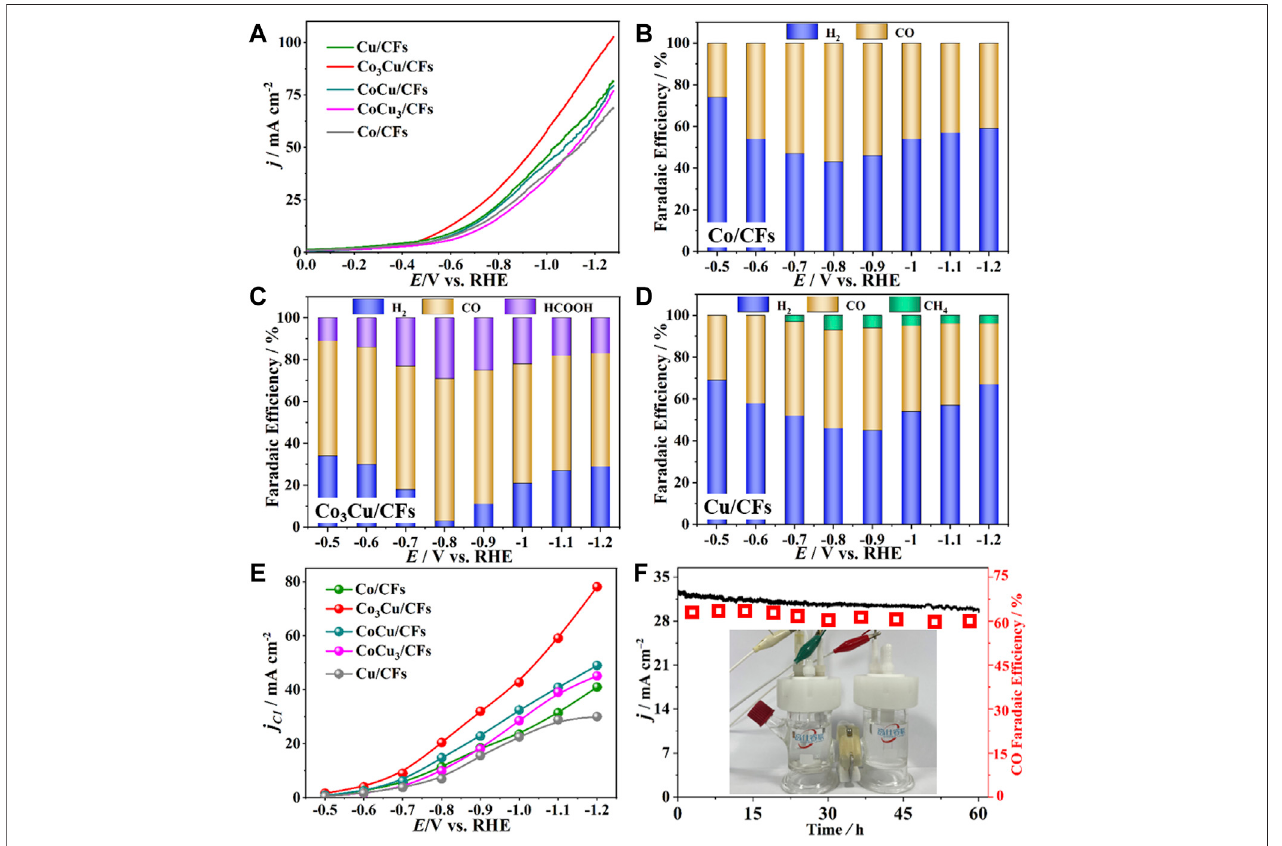
FIGURE4|(A) LSVcurvesofthe fi vesamplesrecordedinaCO Cu/CFs in a 0.5 M KHCO 3 electrolyte; (E) C1 product partial current densities of the fi ve samples; (F) long-term tests of Co 3 Cu/CFs at − 0.8 V RHE in a 0.5 M KHCO 3